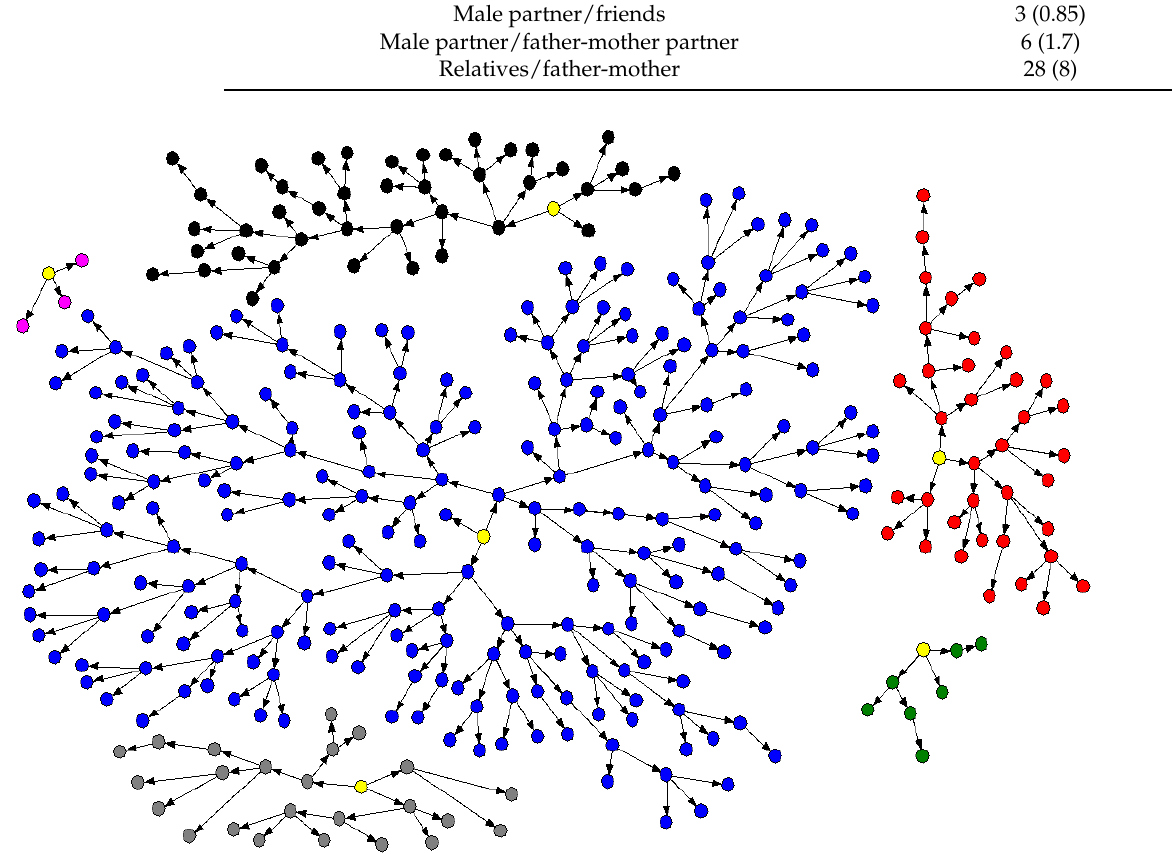
Figure 1. MSM recruitment network in Belém, Pará, Brazil, 2016. Legend: Seeds in yellow originating the networks/clusters represented in black, blue, red, pink, green, and gray.